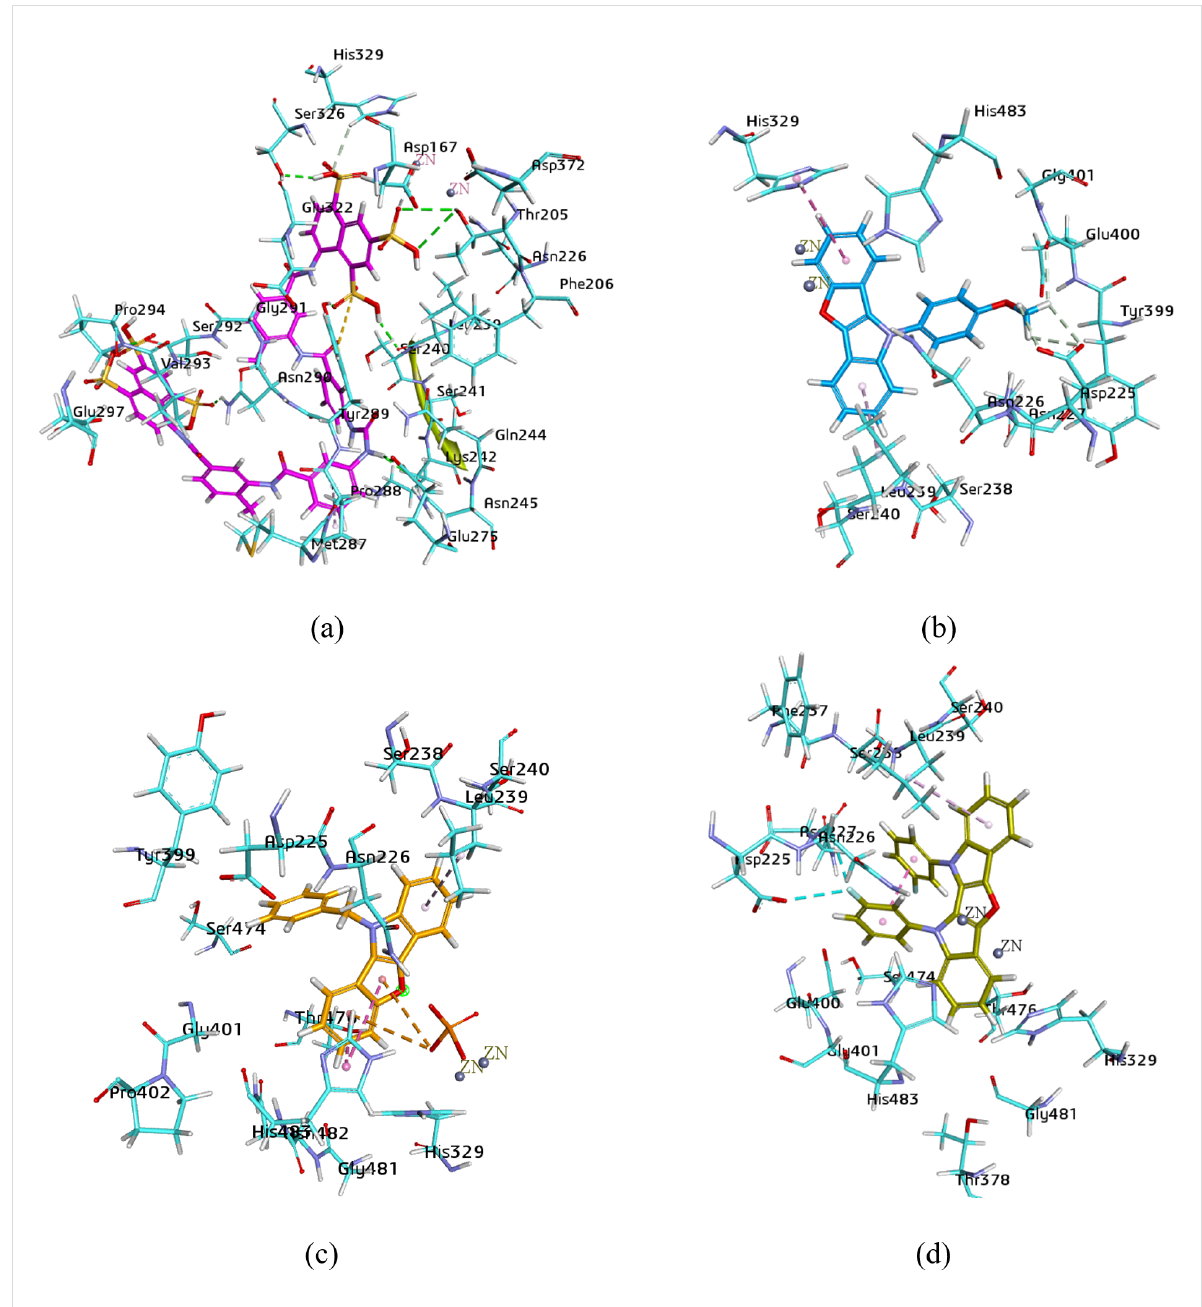
Figure 5: 3D poses of docked selected inhibitors inside homology model of ENPP3. (a): suramin, (b): 5e , (c): 5h , (d): 6e .